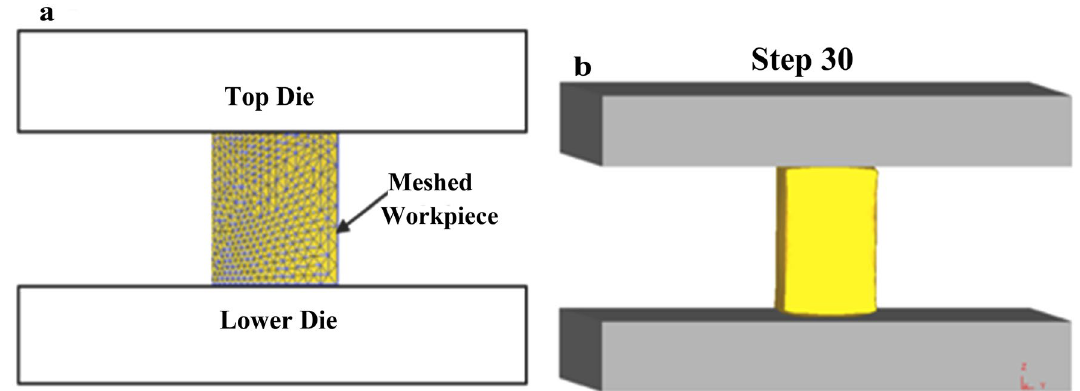
Fig. 2 A schematic diagram of a meshed workpiece ( a ) and a picture of simulation progress ( b